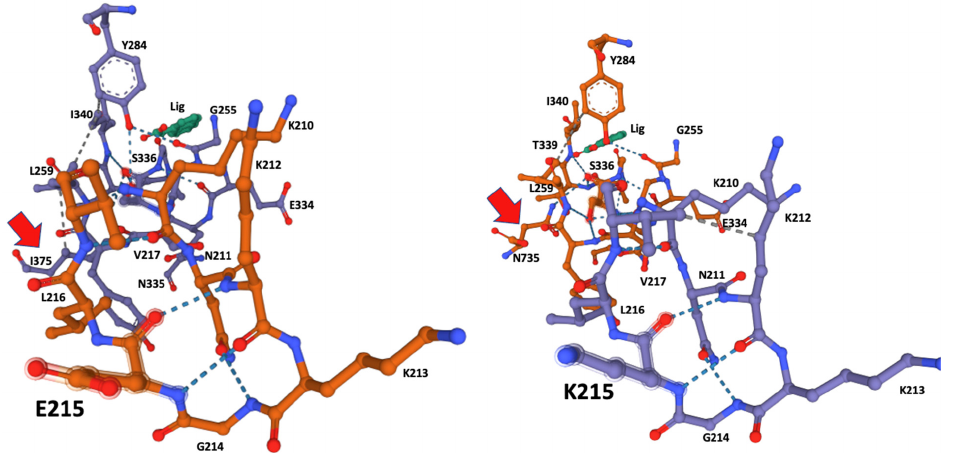
Figure 2. Ligand-docking modeling identifies the amino acids at the binding site in the CestB enzyme. In both alleles the amino acid at position 215 is part of the binding site and a structural reconfiguration takes place depending on the amino acid substitution, relevantly N735 is interacting via hydrogen bond with the catalytic Serine 336 in K215, (right subfigure red arrow), whereas such interaction is only partially replaced by I375 in E215 substitution (left subfigure red arrow). ANA ligand (Lig) was used to locate the position of the catalytic serine within the enzyme active site.